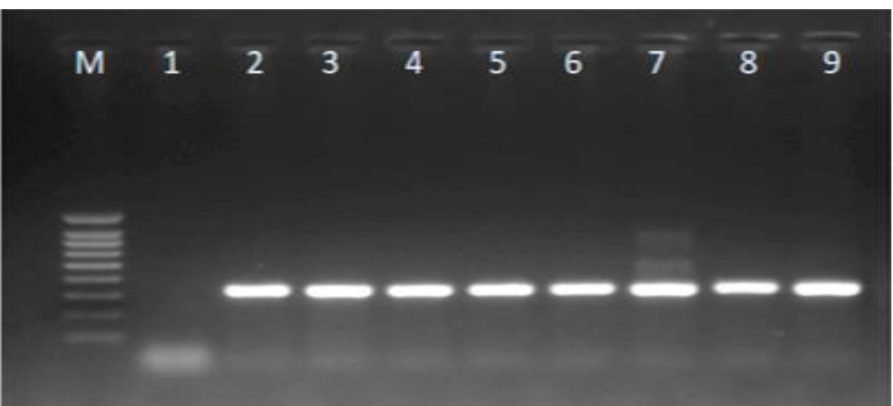
Figure S1 : Confirmation of Y. enterocolitica by PCR (singleplex PCR amplification). M-100bp ladder, lane 1-negative isolate; lane 2-positive control (328bp), Lane 3-9- positive isolates (328bp)